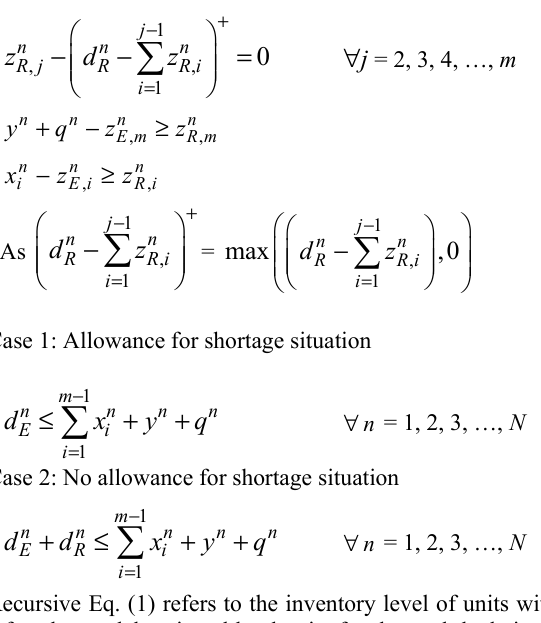
Donation p G ( q n )